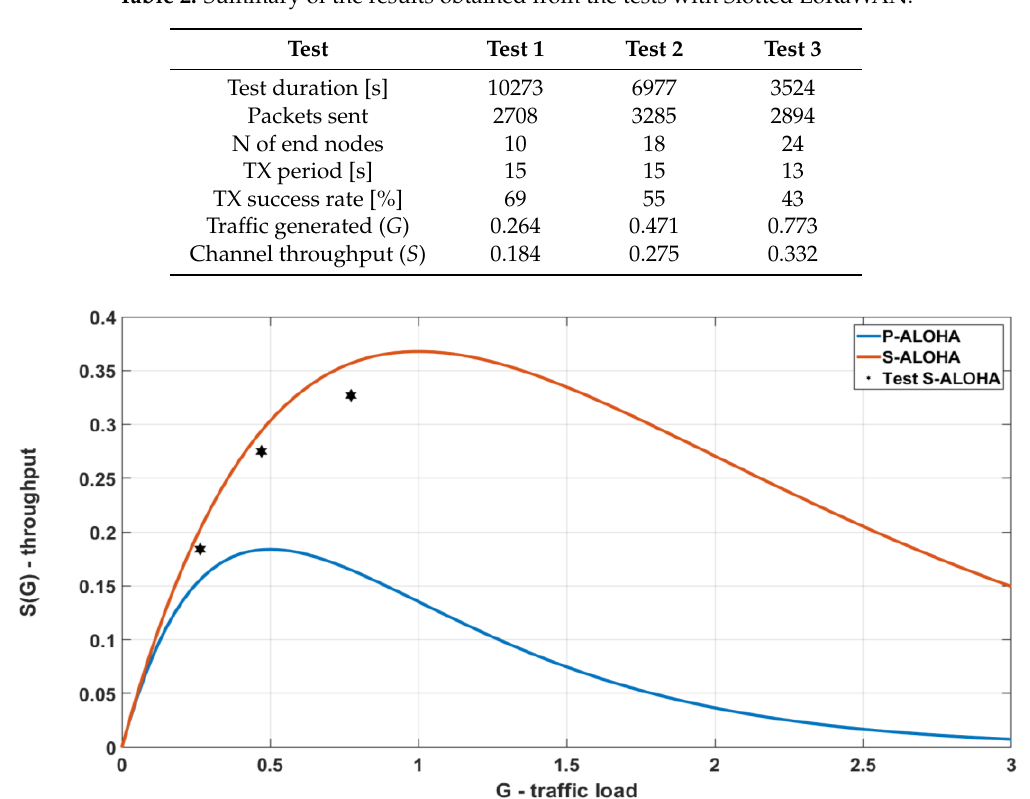
Figure 12. Summary of the results obtained from the tests with Slotted LoRaWAN. Table 2. Summary of the results obtained from the tests with Slotted LoRaWAN.